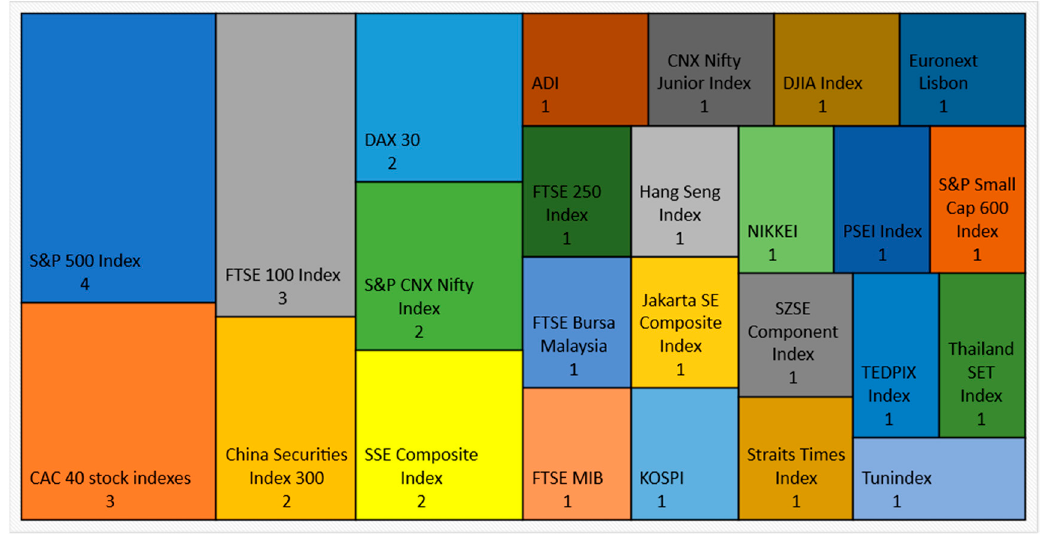
Figure 7. Stock markets covered.